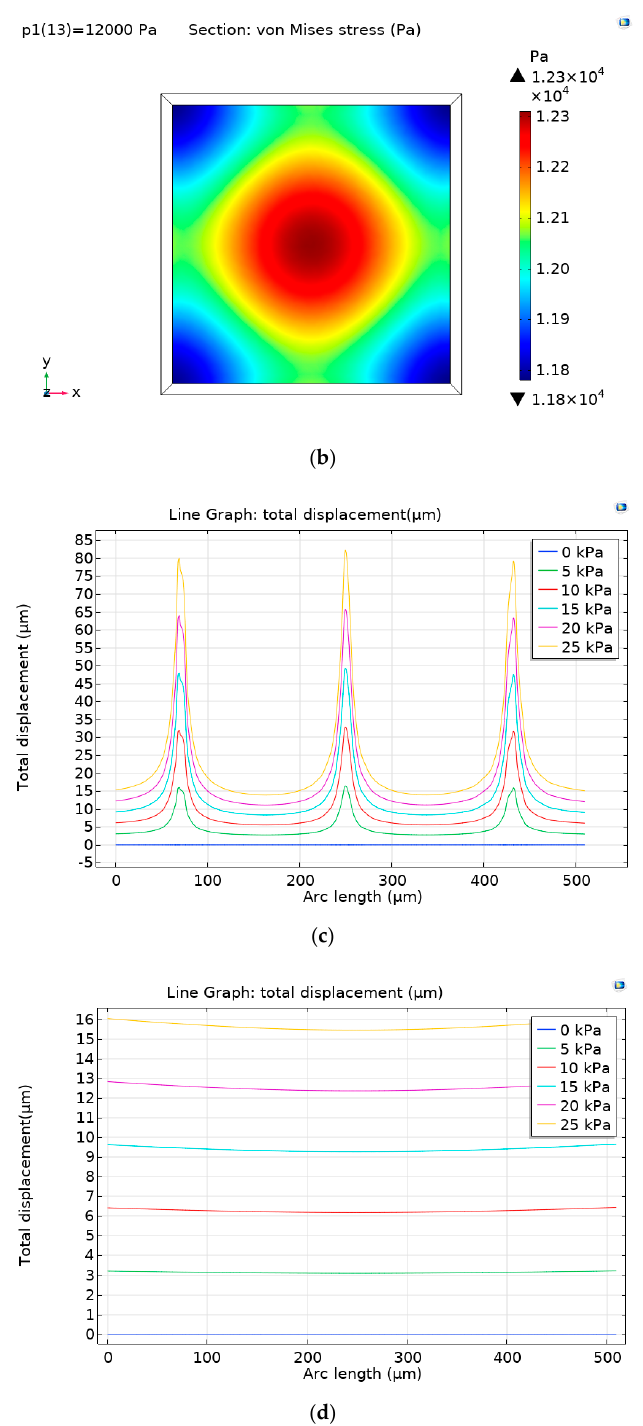
Figure 1. The von Mises stress induced by applying vertical force on the flexible sensor. ( a ) Distri- bution of the von Mises stress induced by applying a vertical force of 12 kPa on the flexible sensor with conical microstructure polydimethylsiloxane (PDMS). ( b ) Distribution of the von Mises stress induced by applying a vertical force of 12 kPa on the flexible sensor with flat PDMS. ( c ) The change of the displacement of three center points under different pressures (0, 5, 10, 15, 20, 25 kPa), the three center points are parallel to the OX axis and located on the same straight line on the substrate with conical microstructure. ( d ) The displacement change diagram by taking the same three center points on the flat substrate after applying 0, 5, 10, 15, 20, 25 kPa pressure,